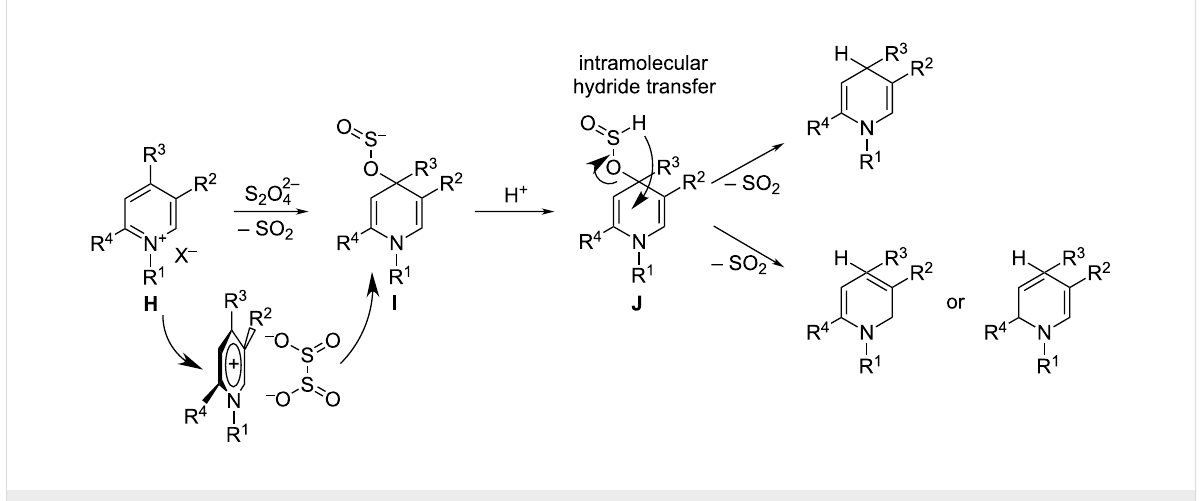
Figure 6: Mechanism of the reduction of the pyridinium core with dithionite as adapted from [67].